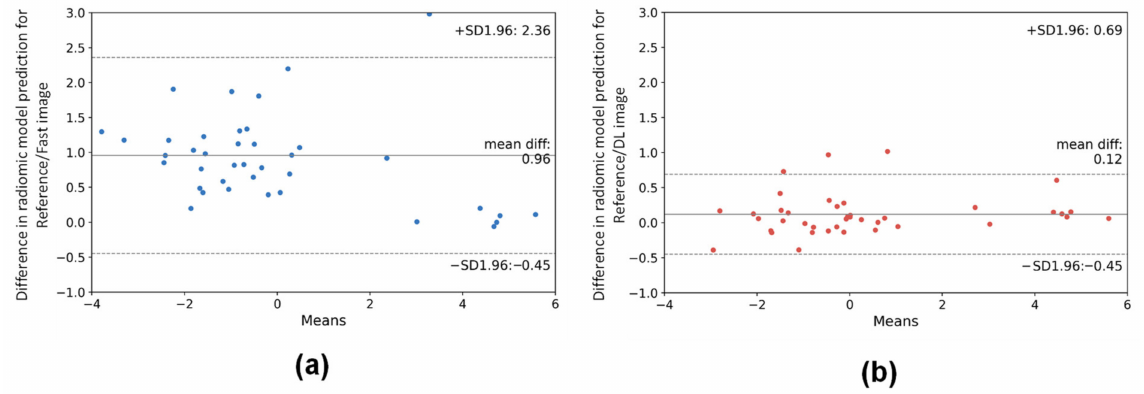
Figure 7. Bland–Altman plots showing the difference between predictive values obtained from radiomic model [29] from reference image to fast noising image ( a ) and DL denoising image ( b ) in brain metastases lesions, n = 40 for both